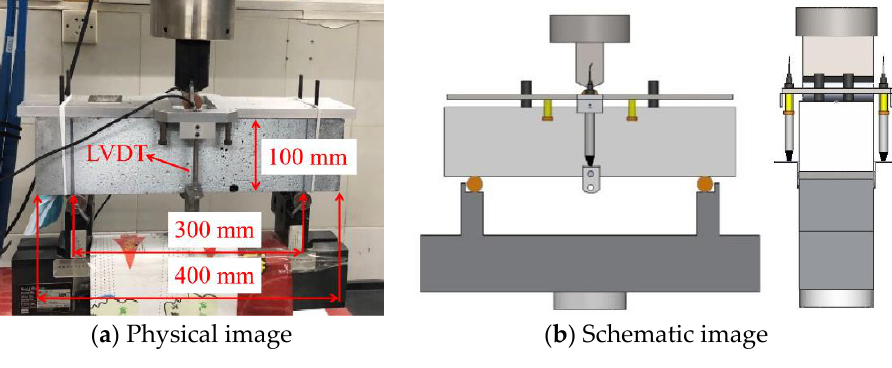
Figure 2. Three-point bending set-up.